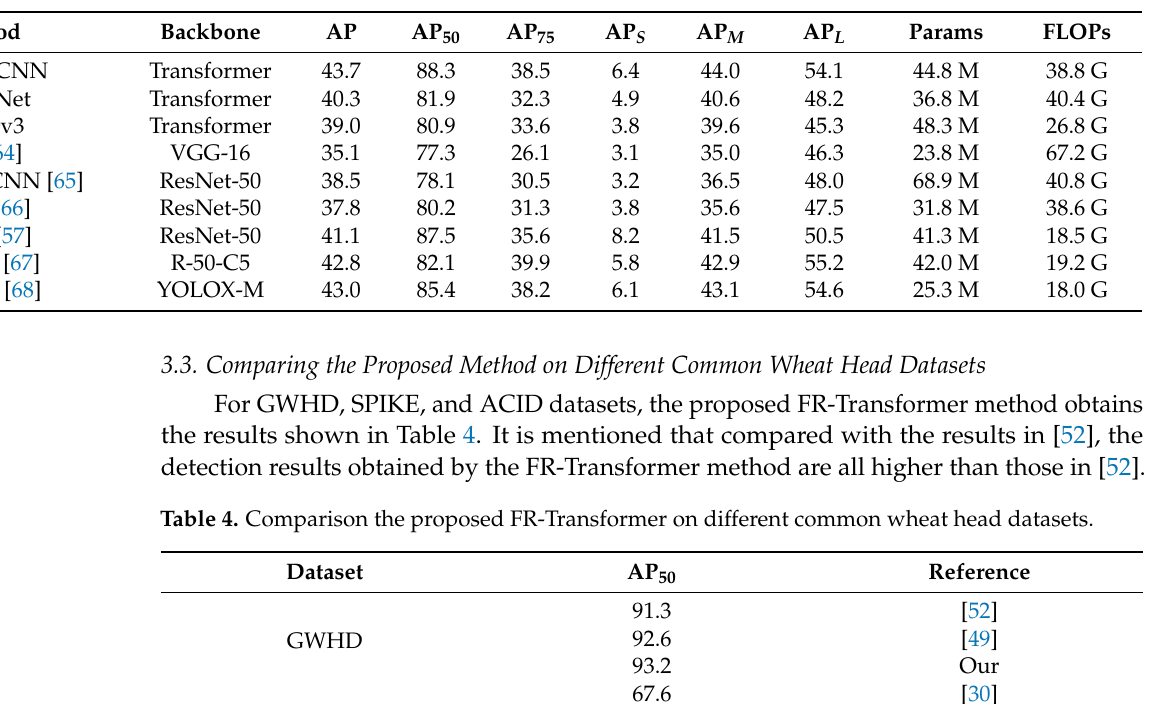
Table 3. Comparison of various object detection methods.